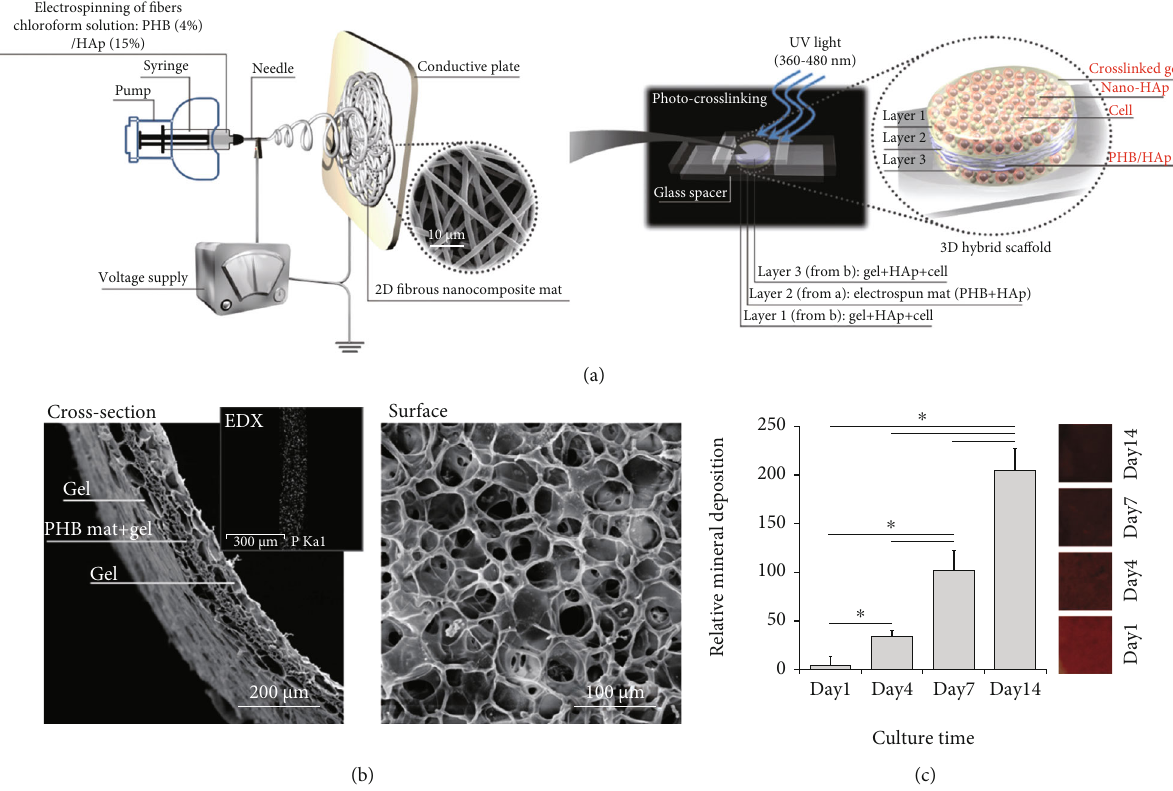
Figure 4: Electrospun nano fi ber/hydrogel 3D sca ff olds for bone tissue regeneration. (a) Schematic diagram of the experimental steps and the structure of 3D cell-laden hybrid sca ff olds. (b) SEM micrographs of surface and cross-section of the freeze-dried hybrid sca ff old. (c) Gross appearance of Alizarin Red staining and mineral quanti fi cation of hybrid sca ff olds after incubation in SBF at 37 ° C for speci fi c periods ( mean ± SD of six replicates). Reproduced with permission from [124]. Copyright © 2016, Elsevier